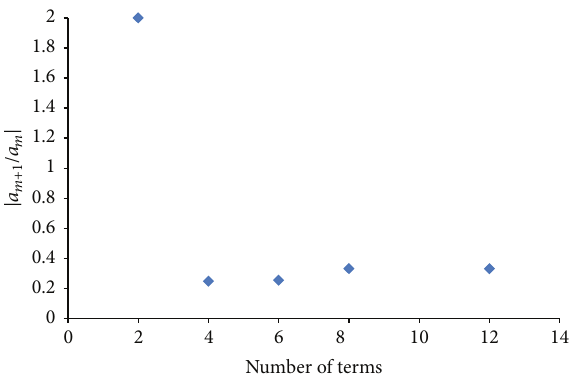
Figure 1: The ratio convergence test applied to the series coefficients (tumour) for MDM and HPM as a function of the number of terms in series.